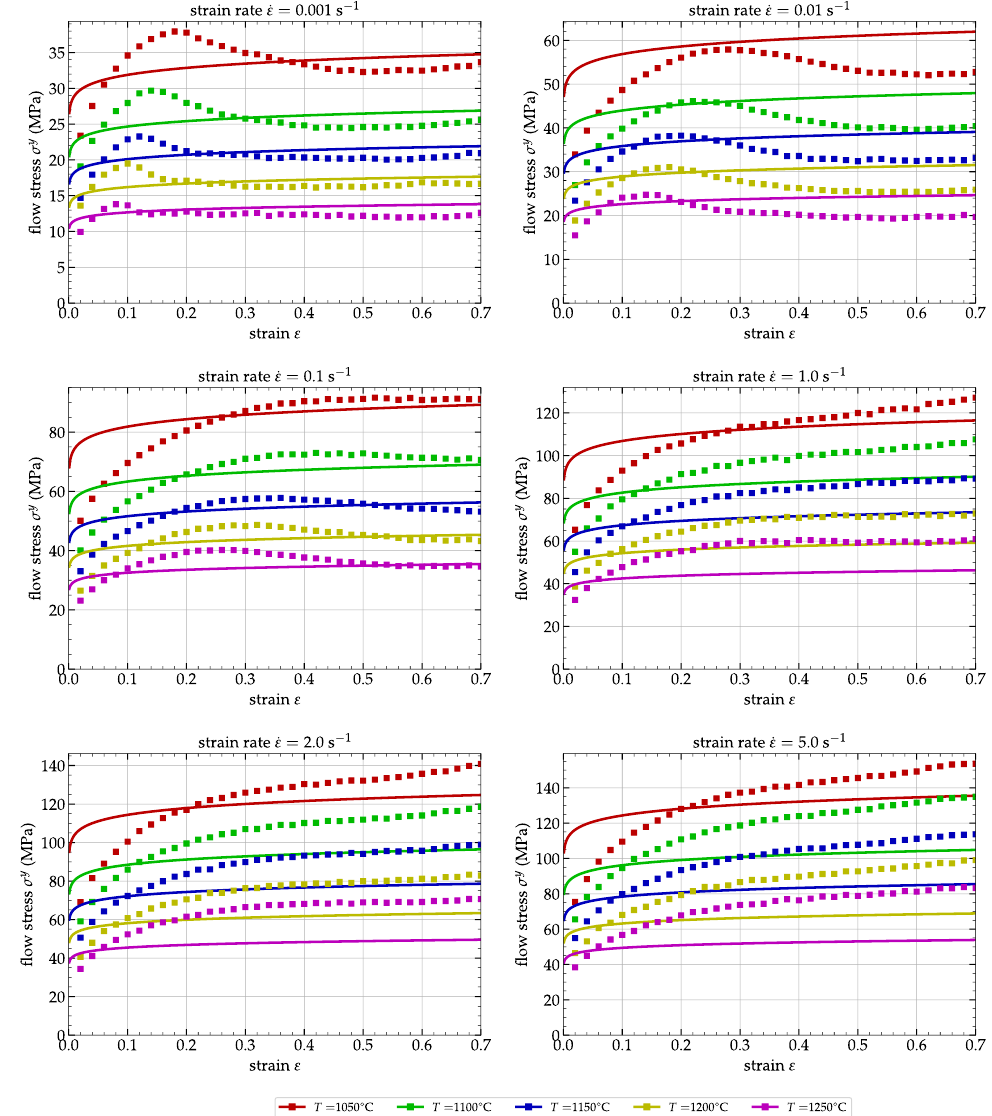
Figure 6. Comparison between the experimental (dots) and predicted (lines) flow stresses σ y by the Johnson–Cook